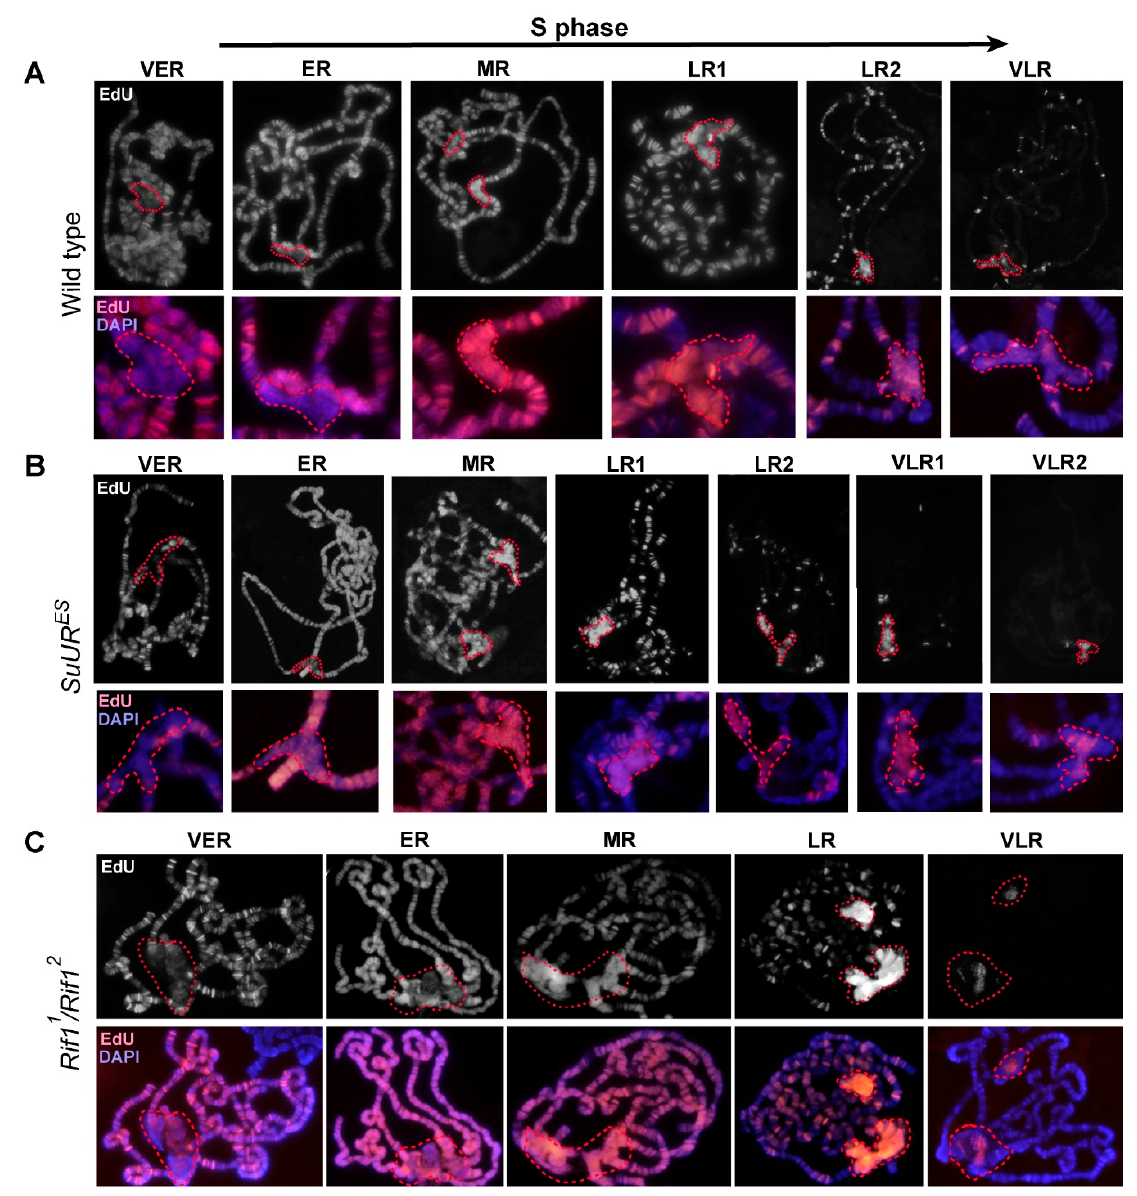
Figure 8. Replication patterns in the salivary glands of the wild-type larvae ( A ), mutants SuUR ES ( B ) and Rif1 1 / Rif2 2 ( C ). Left to right: the stage of early discontinuous labeling (very early replication, VER), the stage of continuous labeling (early replication, ER), the beginning of the stage of late discontinuous labeling (middle S phase, MR), the stage of discrete labeling (late S phase, LR) and the very late S phase (VLR). The stage classification is borrowed from ref [32]. Chromocenters are surrounded by dashed lines.